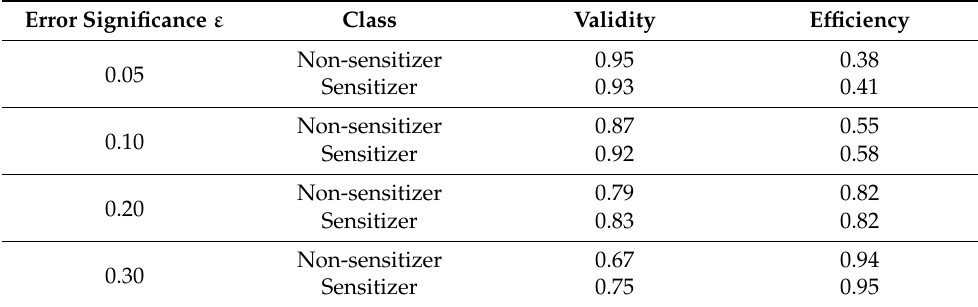
Table 4. Class-wise performance of the model based on ten selected bioactivity descriptors on the test